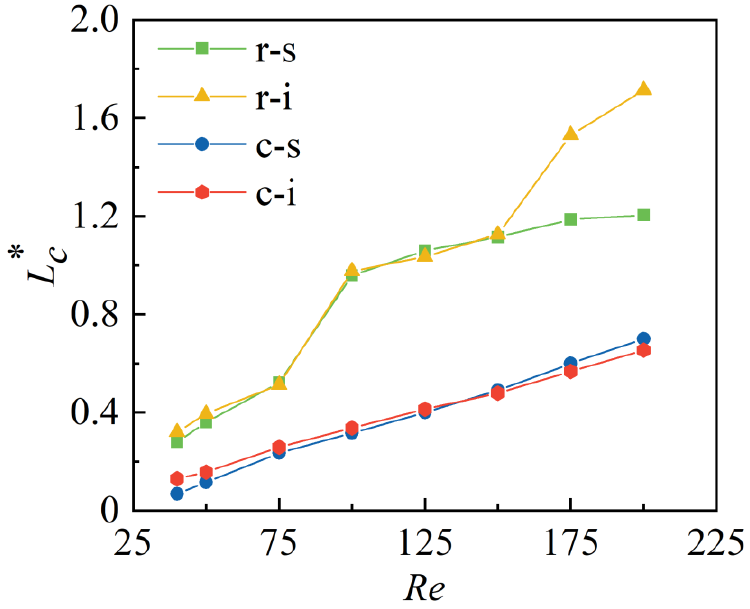
Figure 6. Average dimensionless location of vortex center in four types of micro-pin-fin arrays at different Re .